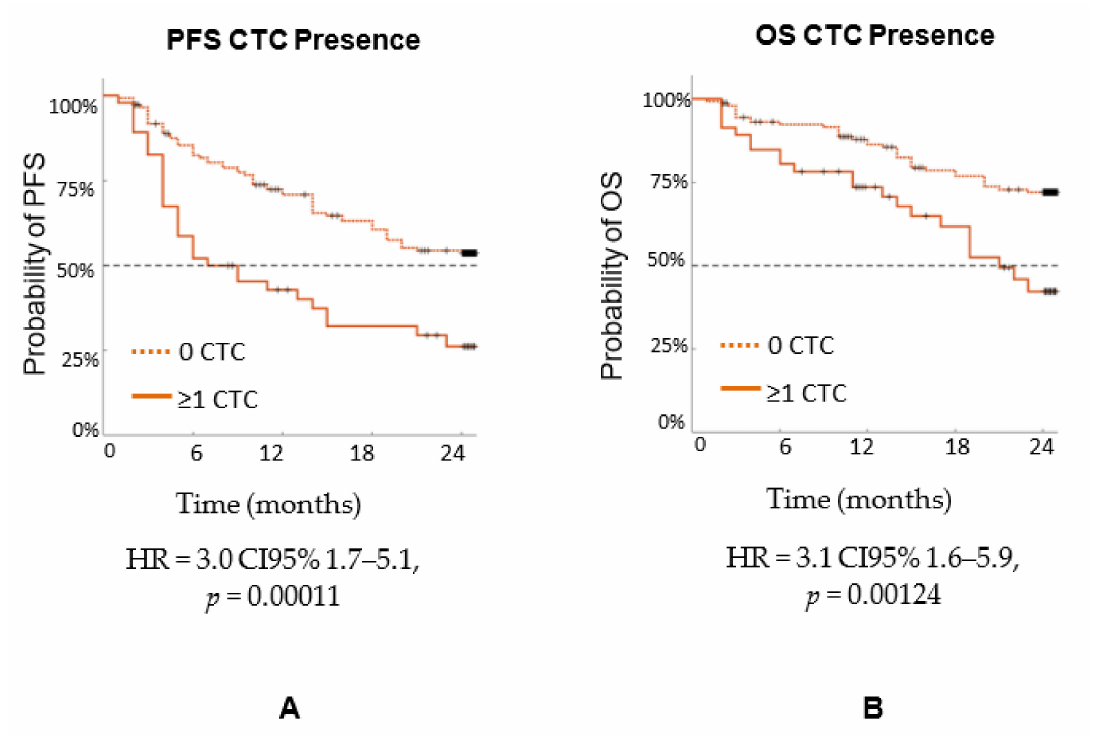
Figure 9. PFS of n = 192 patients with three types of cancers (breast, prostate, and lung) by stage ( A ) PFS and ( B ) OS based on the presence of CTCs, combining all stages.